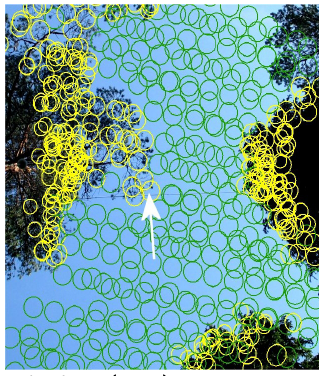
Figure 5. Pseudoechoes (green) at z = 158.69 m and real ec- hoes (yellow) superimposed in an image. The tip of the pine shoot in the center was measured to be at that